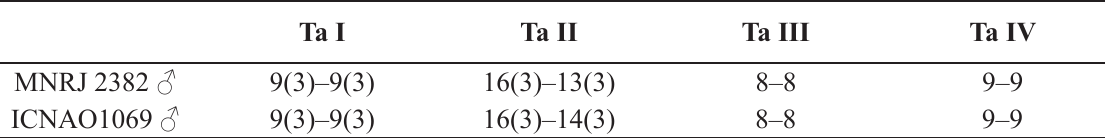
Table 2. Tarsal formula of Phalangodus briareos sp. nov. (numbers in parentheses are the number of